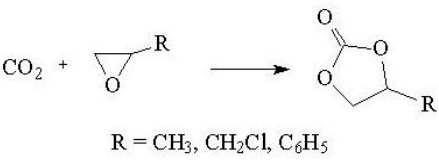
Figure 4. Catalytic properties of ZIFs in the synthesis of cyclic carbonate from CO 2 and epichloro ‐ hydrin (experimental conditions: 18 mmol of EPH, 0.1 g of catalyst, 0.6 MPa of CO 2 , 353 K, 6 h). Kuruppathparambil et al. [74] investigated the effect of Co on the activity of ZIFs in